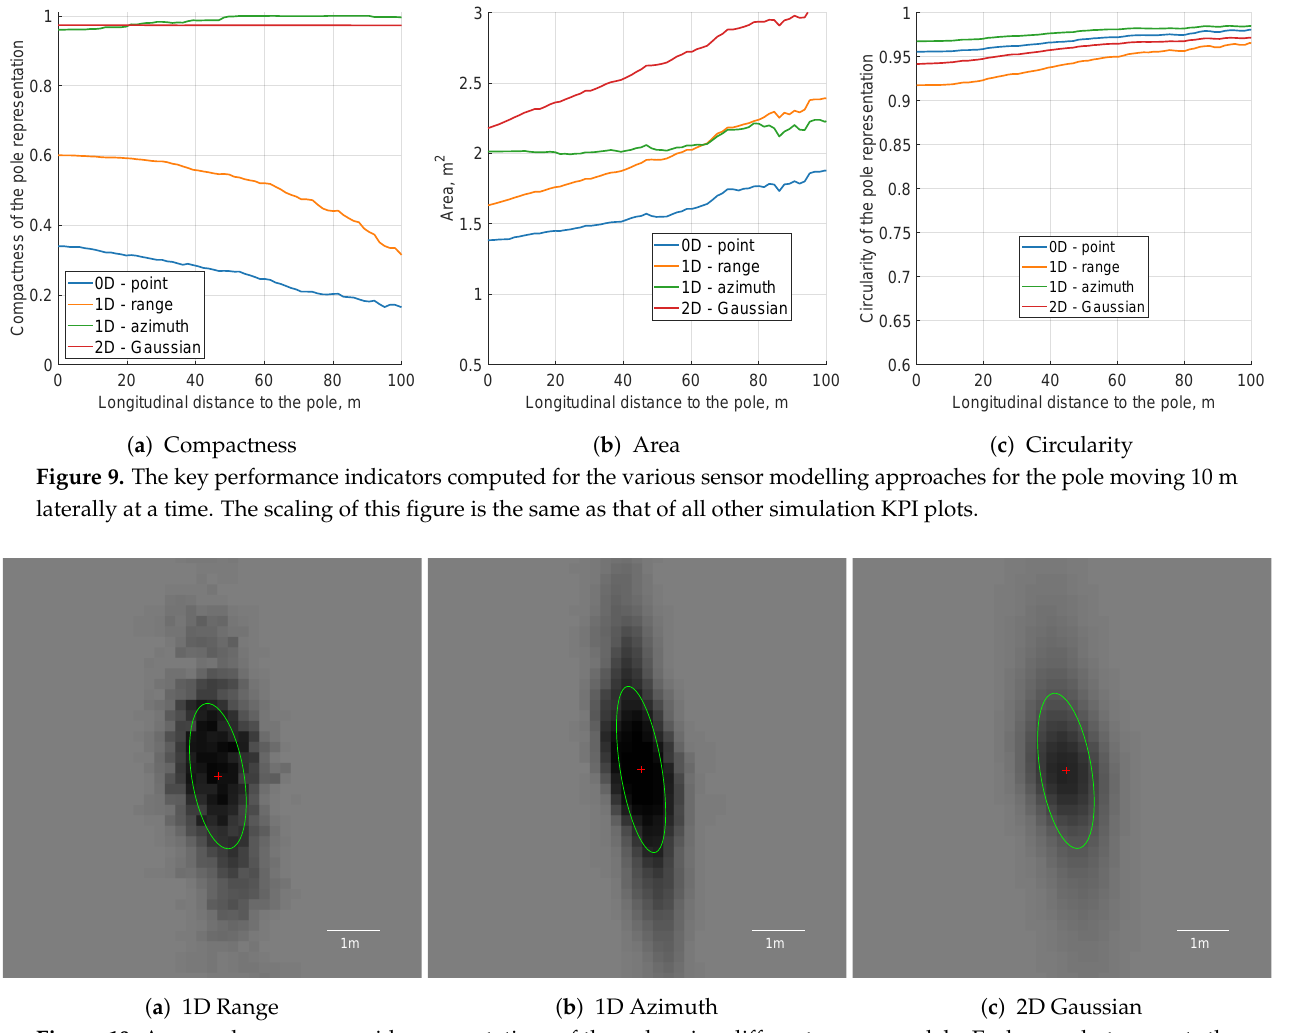
Figure 10. Averaged occupancy grid representations of the pole using different sensor models. Each snapshot presents the pole located 10 m from the left side of the vehicle, captured when the host was 10 m away